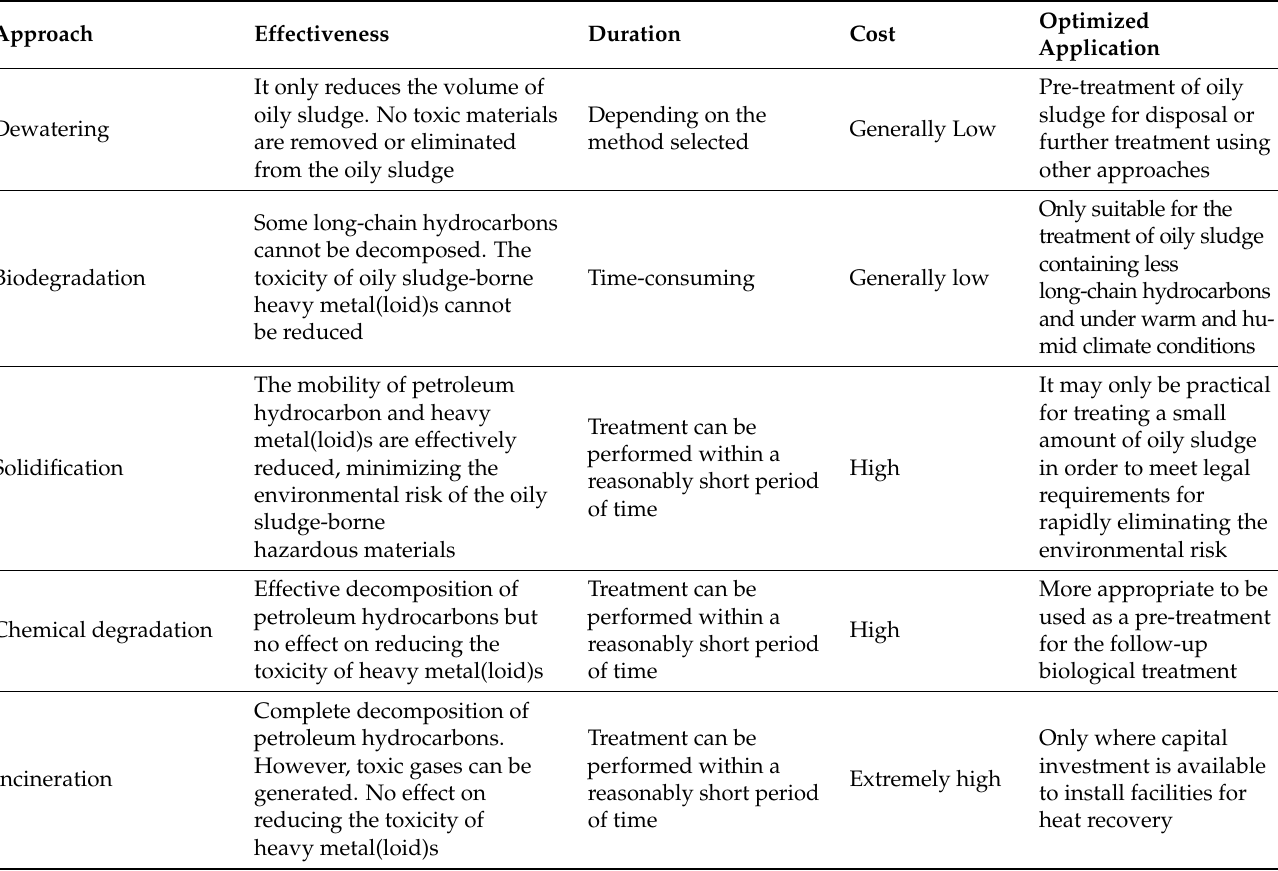
Table 2. A comparison of the features, limitations, and optimized applications among the five major treatment approaches for hazardousness reduction of oily